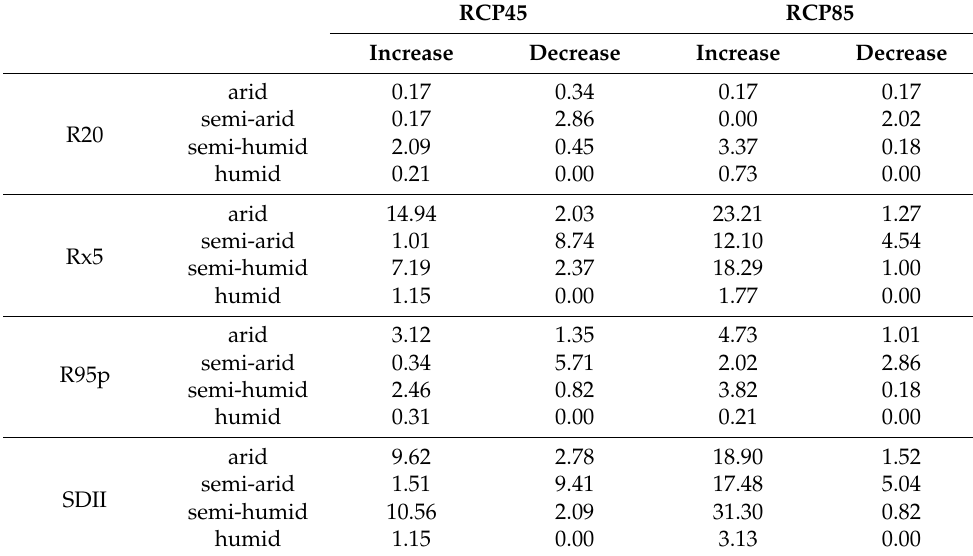
Figure 9. The difference in precipitation index anomalies between RCP4.5 and RCP8.5 scenarios (RCP8.5 minus RCP4.5) in 2006–2099. Table 3. The area proportions (%) of the four regions with statistically significant trends (at the 95% significance level) of four precipitation indictors in